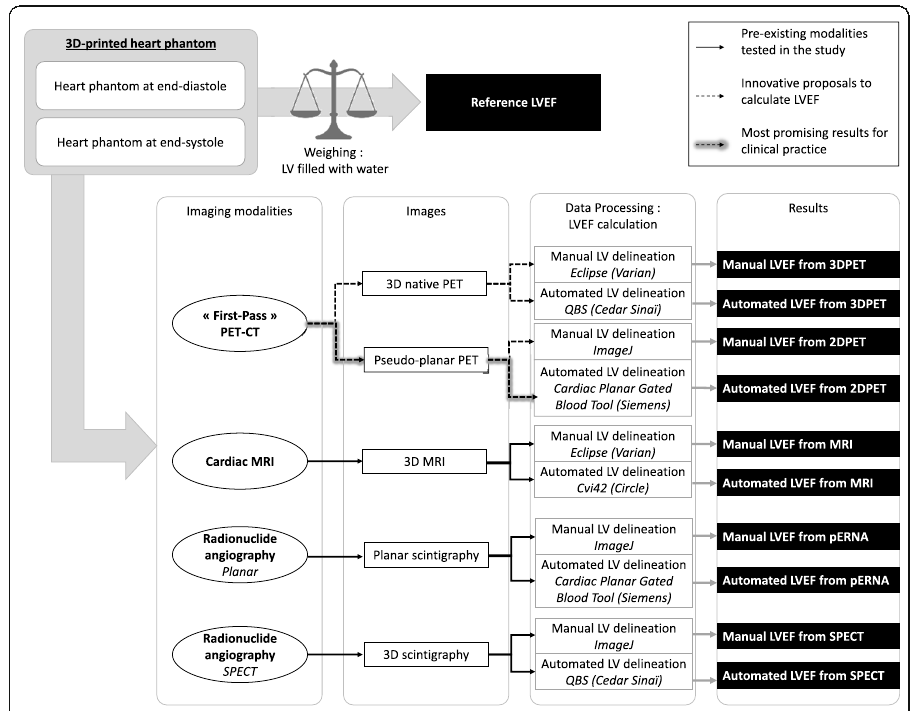
Fig. 1 Schematic depiction of the protocol used to determine the LVEF in the heart-phantom pair. CT, computed tomography; LV, left ventricle; LVEF, left ventricular ejection fraction; MRI, magnetic resonance imaging; QBS, quantitative blood pool SPECT; PET, positron emission tomography; pERNA, planar equilibrium radionuclide angiocardiography; SPECT, single-photon emission computed